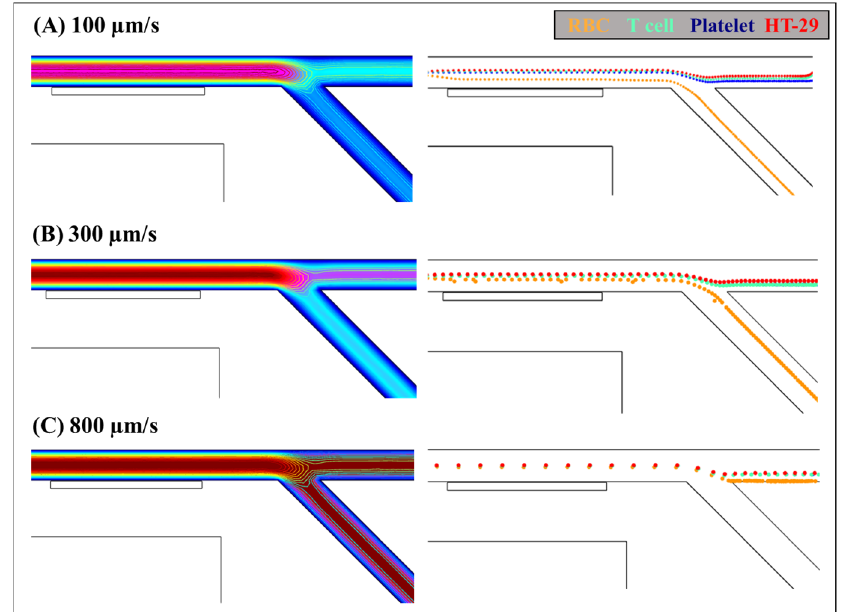
Figure 5. The effect of the flow rate on the separation of RBCs, T cells, platelets, and HT-29 by the integrated MAP-DEP microchannel. The dependence of the cell trajectories on pressure-driven flow with cell velocity of ( A ) 100, ( B ) 300, and ( C ) 800 μ m/s. The width of the channel is 80 μ m and the residual magnetic flux density is 1T.